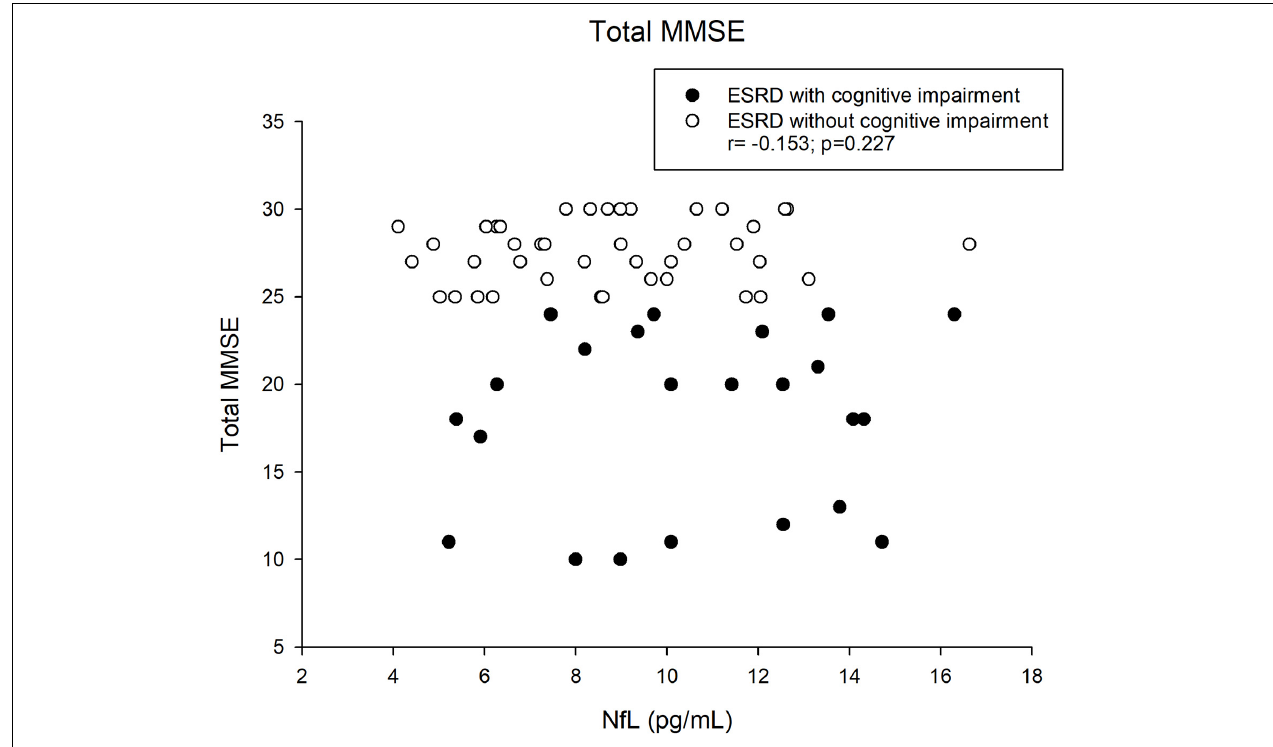
FIGURE 3 | Correlation between NfL and total MMSE in ESRD